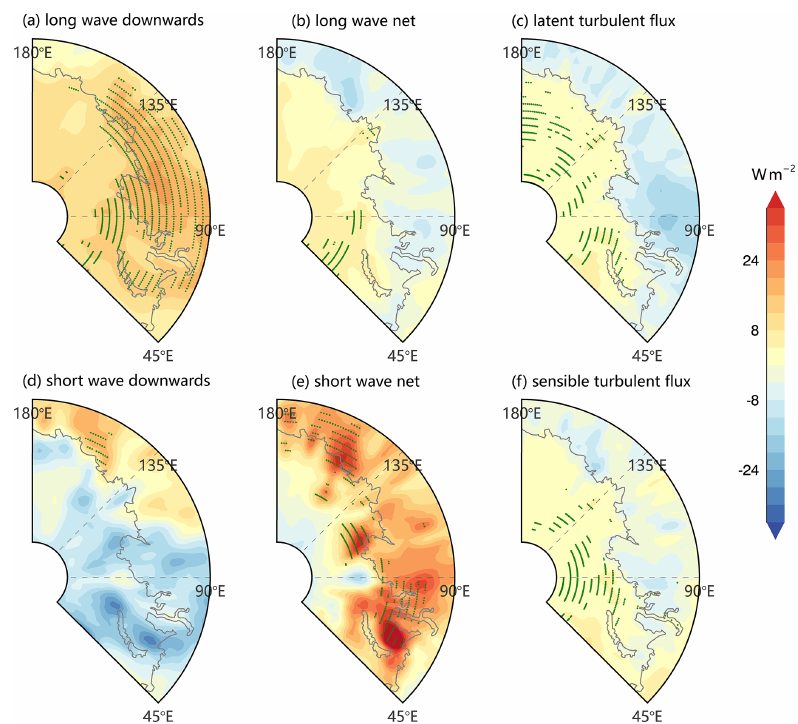
Figure 5. Anomalies of surface (a) downwelling and (b) net longwave radiation, (d) downwelling and (e) net shortwave radiation, as well as sensible (c) and latent (f) heat fluxes. The anomalies are calculated as the difference between the averaged fields of the 3 months (April to June) and the corresponding 1979–2020 climatology. The stippled grids denote those with anomalies exceeding 2 standard deviations. Note that the plotted view is slightly larger than the study area for better